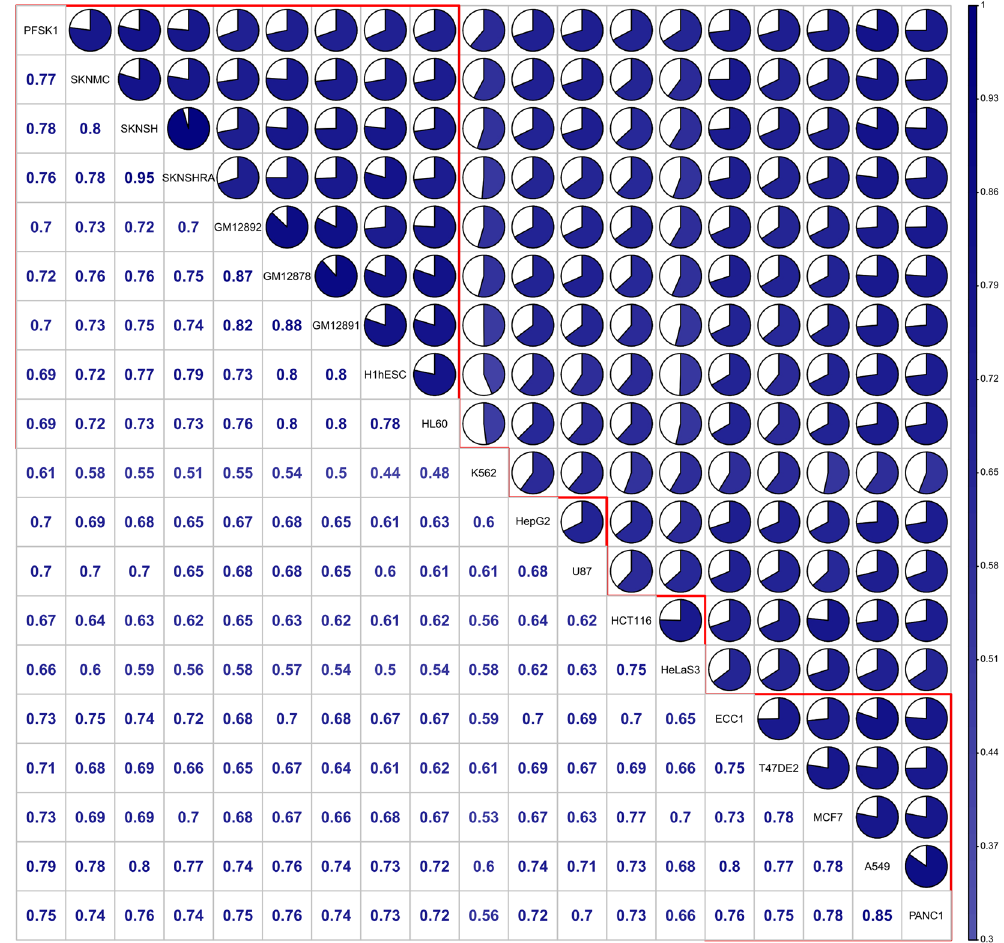
Figure 2. Genome-wide Pearson correlation chart for DNA methylation CpG base profiles across 19 cell types. Each diagonal entry gives cell name, upper off-diagonal entry denotes pie chart for the pairwise correlation level and lower off-diagonal entry denotes the corresponding pairwise correlation coefficient for genome-wide methylation of each cell line. The detailed corresponding methylation (Illumina Infinium 450 K) statistics for each cell line was in the Supplemental Material Section